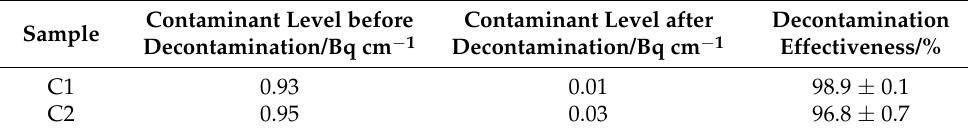
Table 2. Decontamination properties of two polymeric coatings.